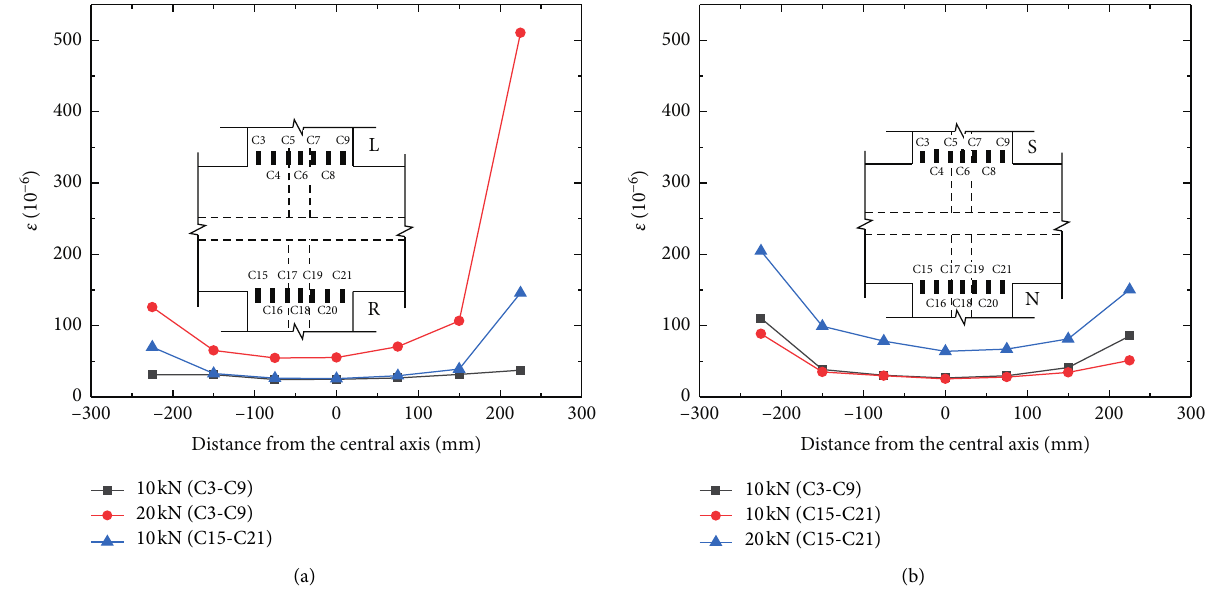
Figure 15: Strain distributions of slabs. (a) BGJ1 and (b)